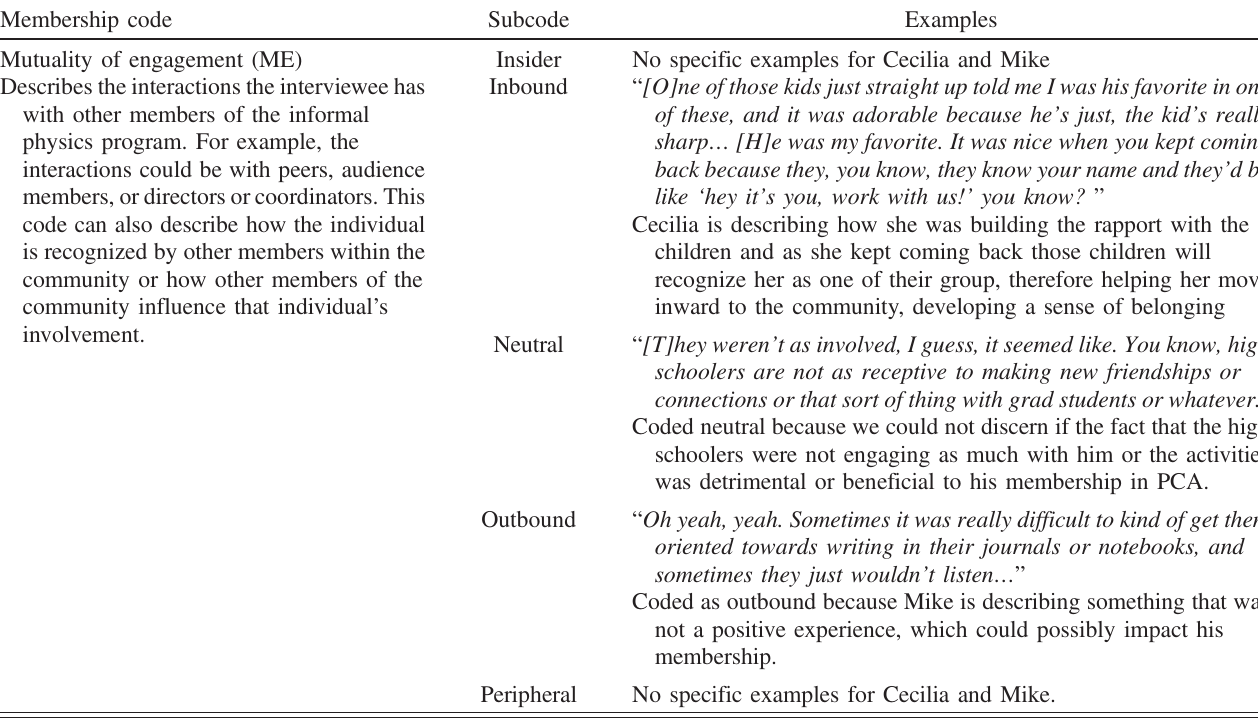
TABLE IV. Examples and explanations for each subcode under the mutuality of engagement